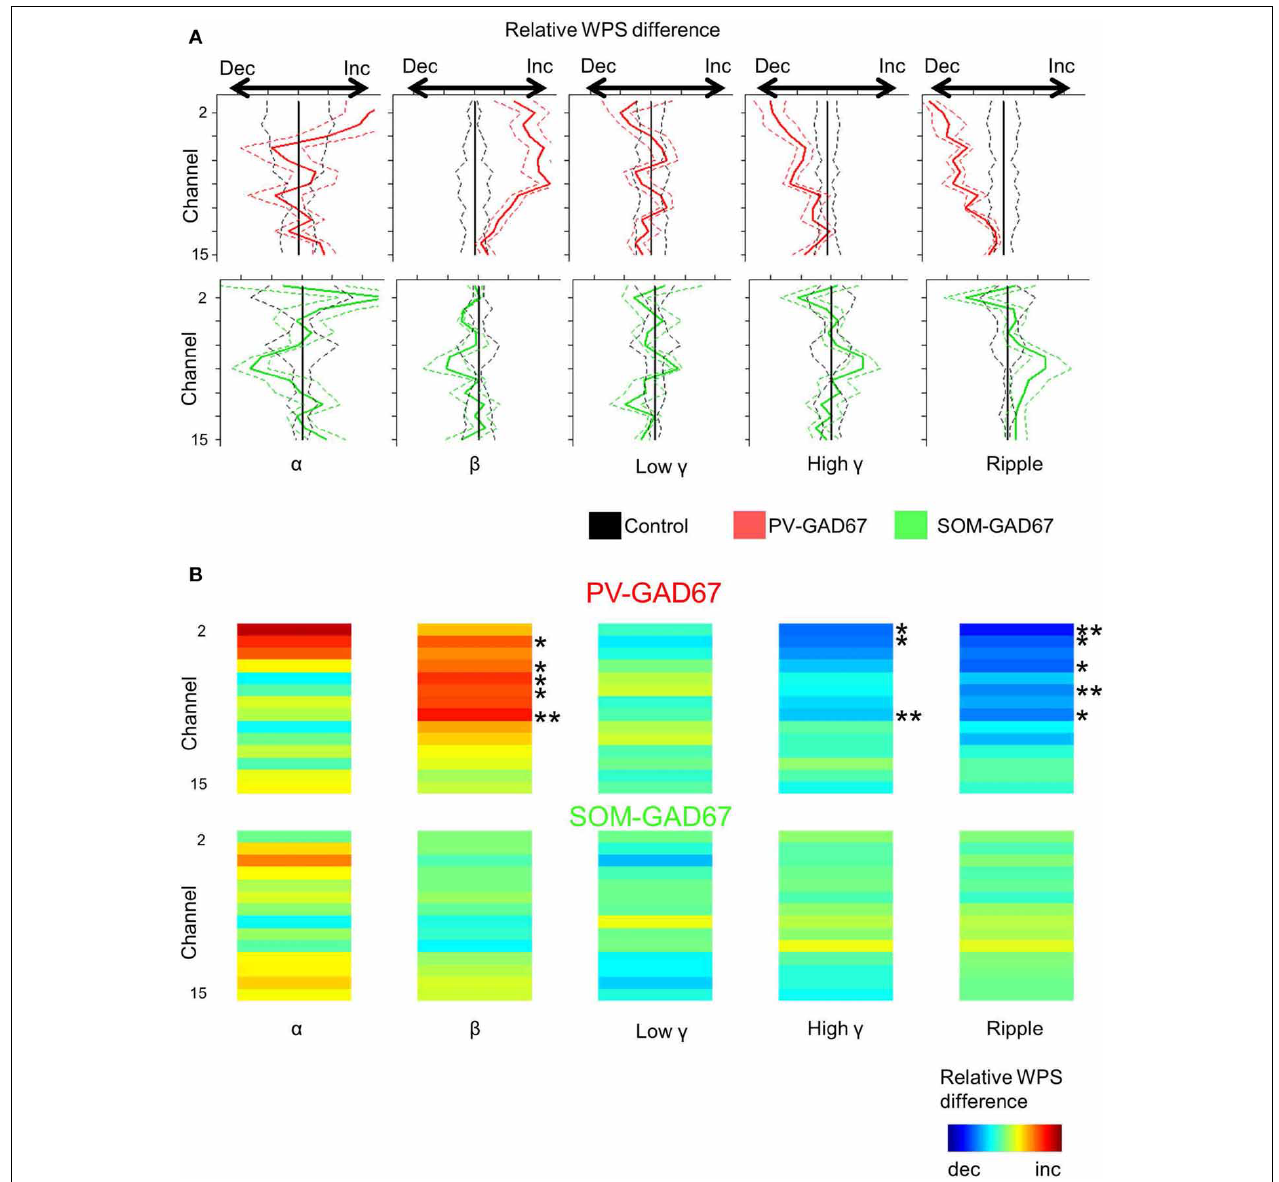
FIGURE 6 | Comparison of the CSD wavelet power spectrum depth profile in each high frequency band between PV-GAD67 or SOM-GAD67 and control mice. (A) Comparison of the CSD WPS depth profile average in each high frequency band. Comparisons between the PV-GAD67 and control mice and between the SOM-GAD67 and control mice are shown in the upper and lower panels, respectively. The frequency range in each band from left (alpha) to right (ripple) is the same as that described in Figure 5 . Red line,